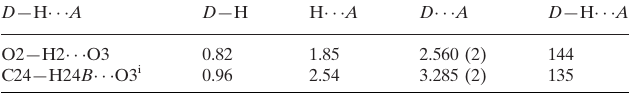
Hydrogen-bond geometry (A˚ , (cid:3)